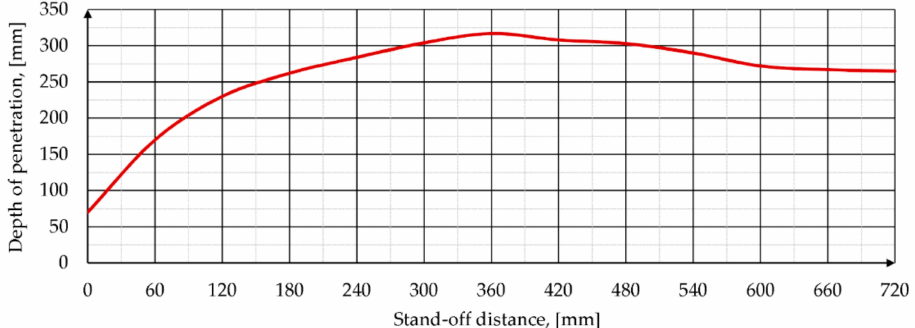
Figure 18. Characteristic of the PG-7VM warhead efficiency—DoP as a function of